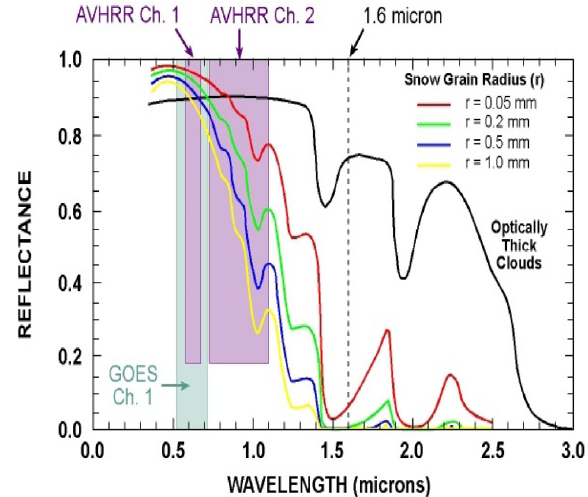
Fig. 1. The reflectance spectrum of clouds and snow for different grain sizes. In the visible and near-infrared both spectra are simi- lar in magnitude and shape but in the shortwave infrared (1.4–3.0 µ ) snow shows a significantly lower reflectivity compared to clouds. (Source: National Snow and Ice Data Center, University of Col- orado,